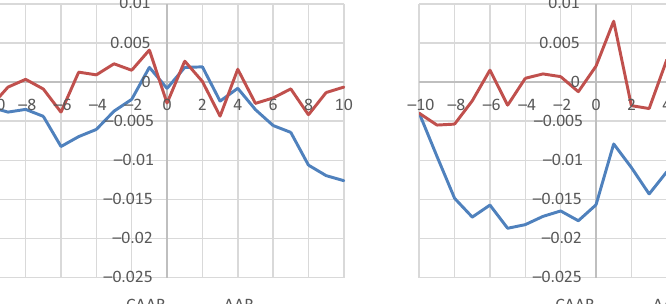
Figure 5. Market reaction of last year ’ s net income sub-groups